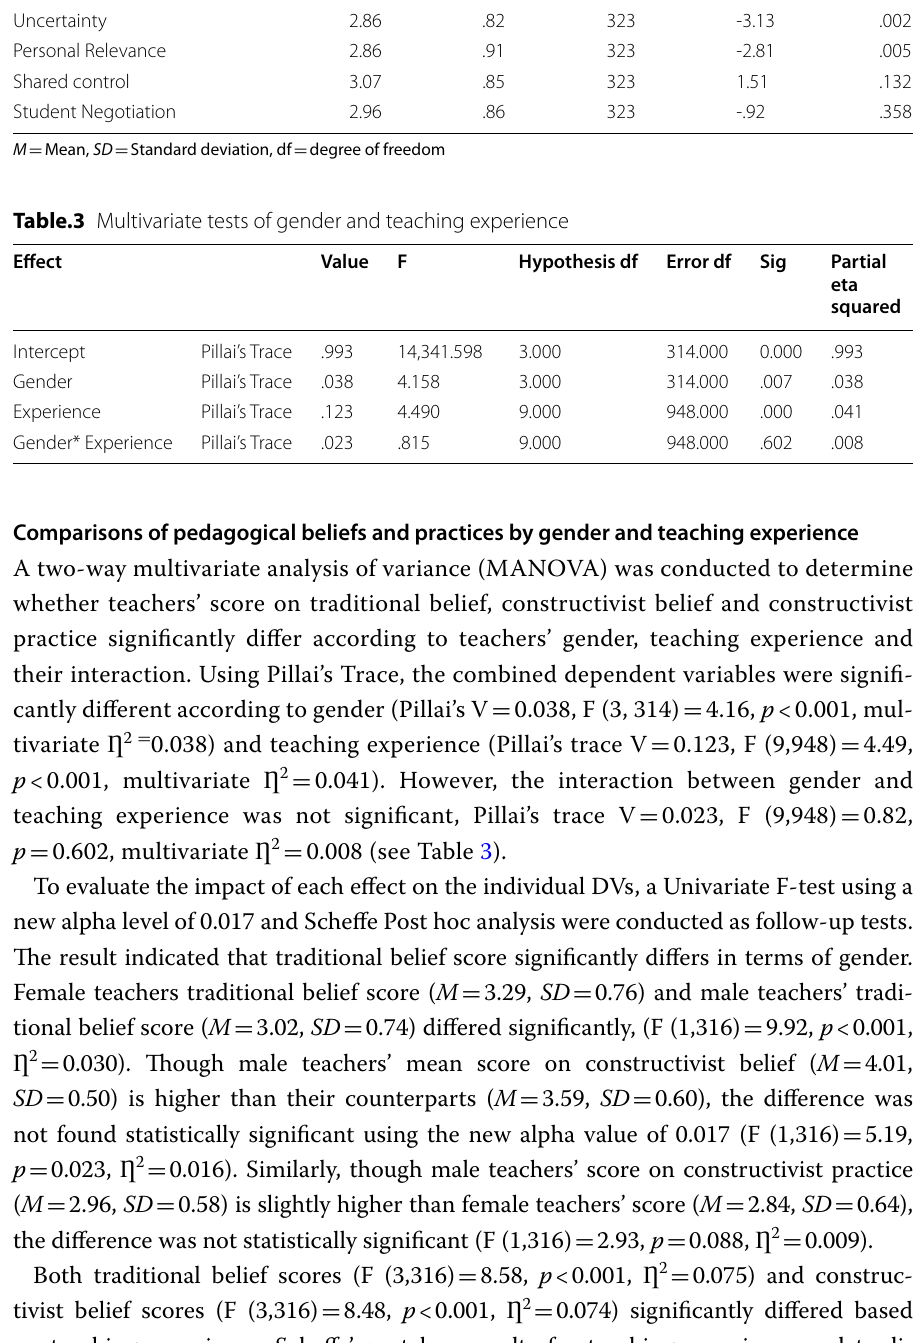
Table.2 Mean, standard deviation and one sample t-test results of variables M SD df t p